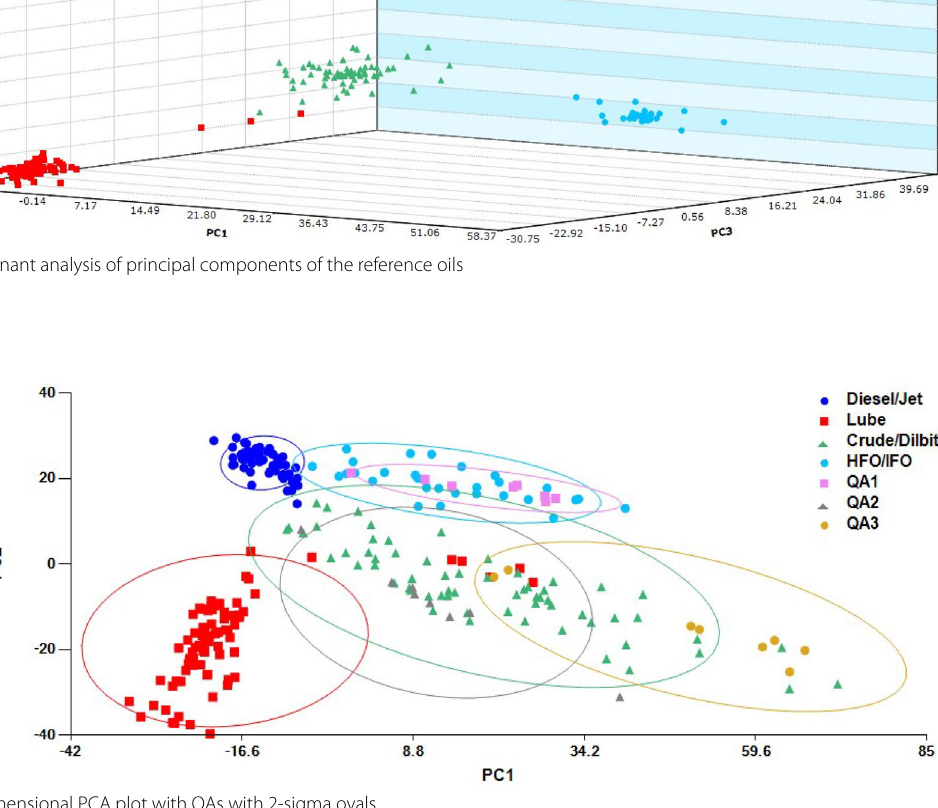
Fig. 7 Two-dimensional PCA plot with QAs with 2-sigma ovals